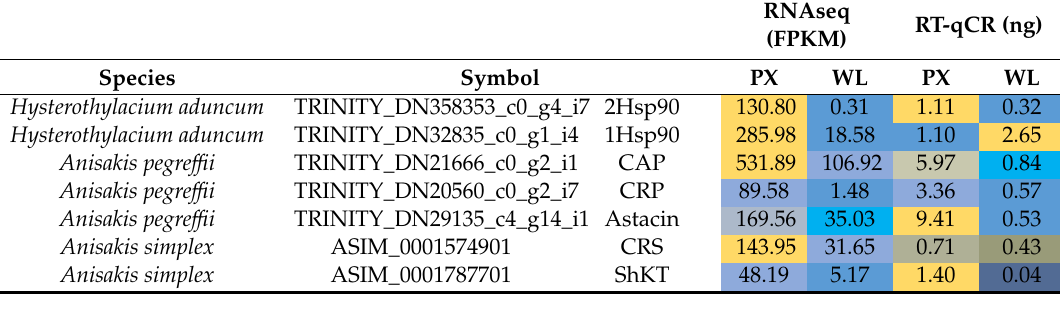
Table 6. Heat-Map. RNA-seq abundance values of selected transcripts are reported (FPKM) and compared to relative quantifications obtained by RTqPCR (ng). Transcripts putative encoded peptides, contigs ID and species are also indicated. Colors in the Heat-Map are assigned separately for each species according to percentiles criteria, with blue referring to lower values (10 percentile) and yellow to higher values (90 percentile).